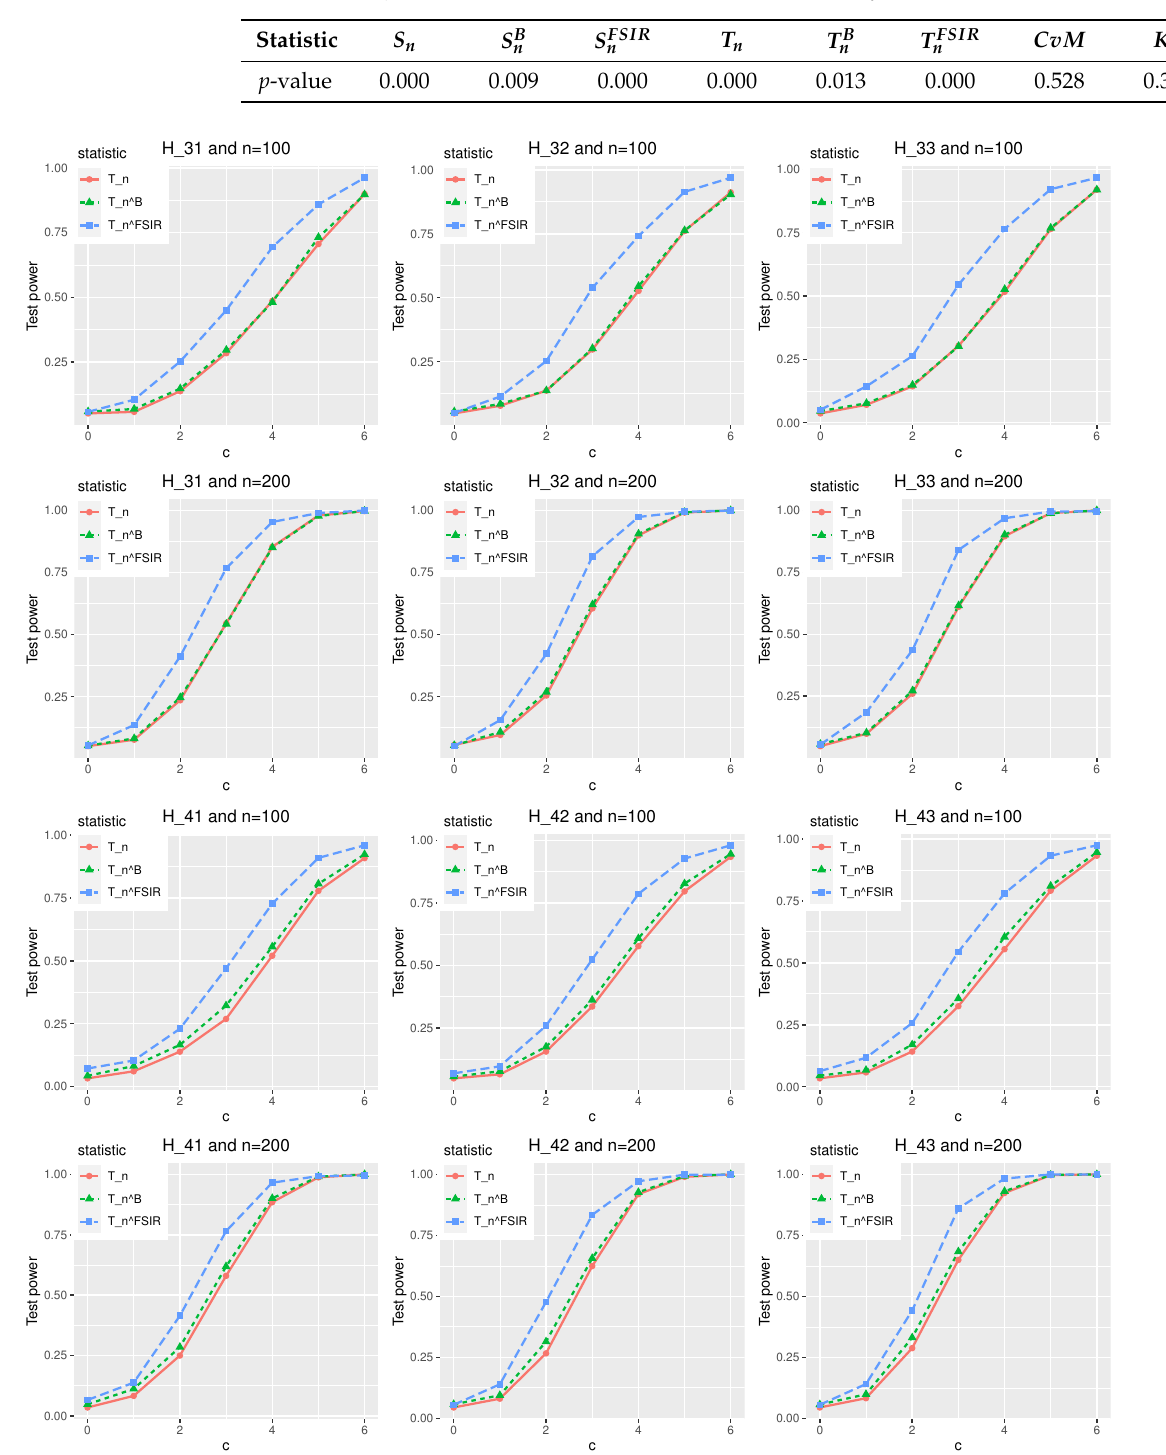
Table A3. The p -value of different test statistics in real data analysis.